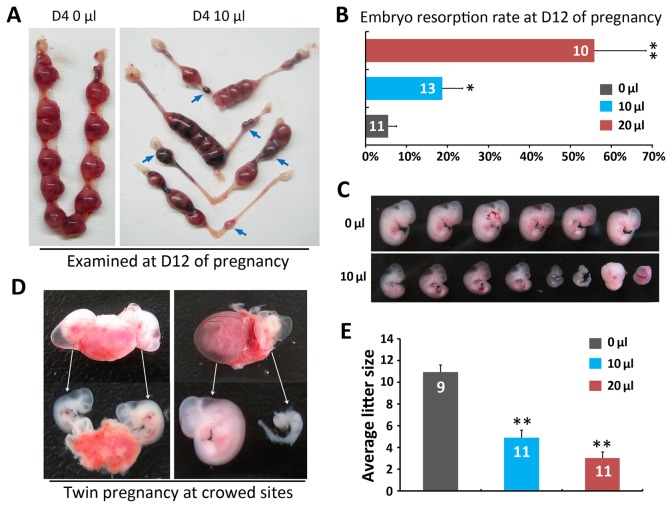
Abnormal timing and spacing of embryo implantation after intrauterine fluid infusion caused pregnancy loss at mid-gestation.(A) Demonstrative photos of Day12 uteri after 0 μl and 10 μl intrauterine fluid infusion on Day4 morning. Red arrows showed abnormal implantation sites (retarded growth/crowded site). (B) Embryo resorption rate at Day12 after 0 μl, 10 μl and 20 μl intrauterine fluid infusion on Day4 morning (*P < 0.05, **P < 0.01) t test, Error bars represent S.E.M ). (C) Representative photos of normal embryo and retarded/resorbed embryos from 0μl and 10 μl groups at Day12. (D) Examples of twin pregnancy discovered at crowed implantation sites on Day12, note that two embryos were grown on one placenta, in the right panel, one of the twin embryo showed severely retarded growth and tended to be resorbed. (E) Average litter size at birth (**P < 0.01) t test, error bars represent S.E.M. Numbers within bars indicate the number of mice examined.